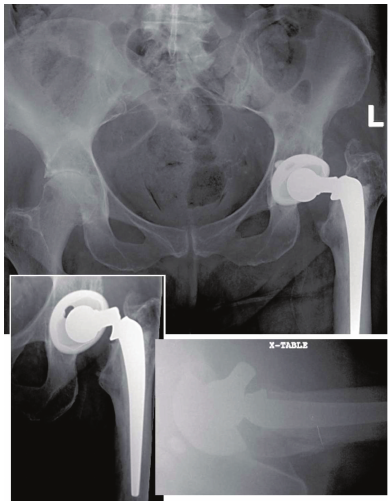
Figure 1: Admission radiographs show femoral component fracture at the neck-shoulder junction at 12 years after